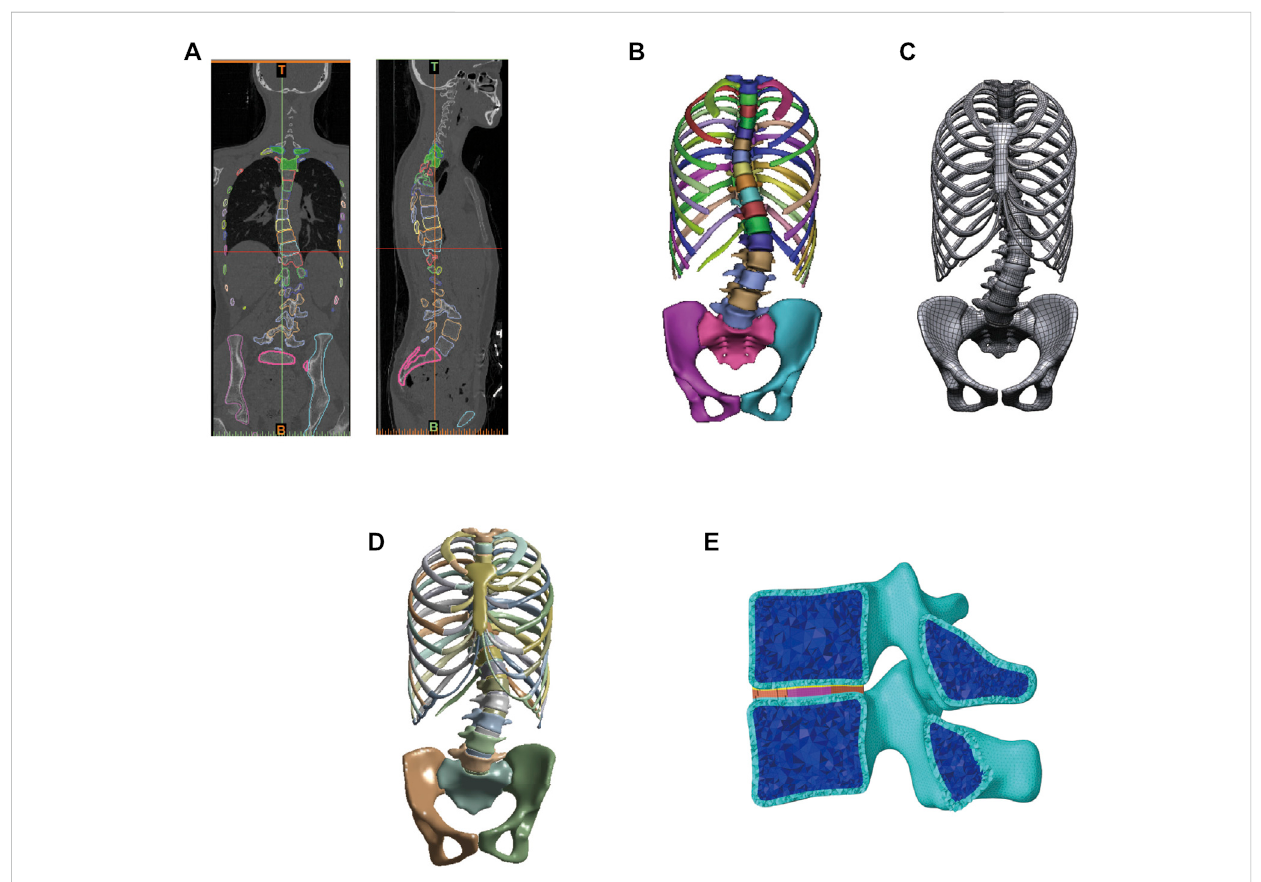
Establishmentofthe fi niteelementmodelofpatientwithscoliosis. (A) ConstructingthebonestructurebyusingCTdataofscoliosispatient. (B) Bone structure model. (C) Bone structure of reverse engineering into the geometric model and soft tissue establishment. (D) Global fi nite element model of scoliosis. (E) Finite element model of the vertebral